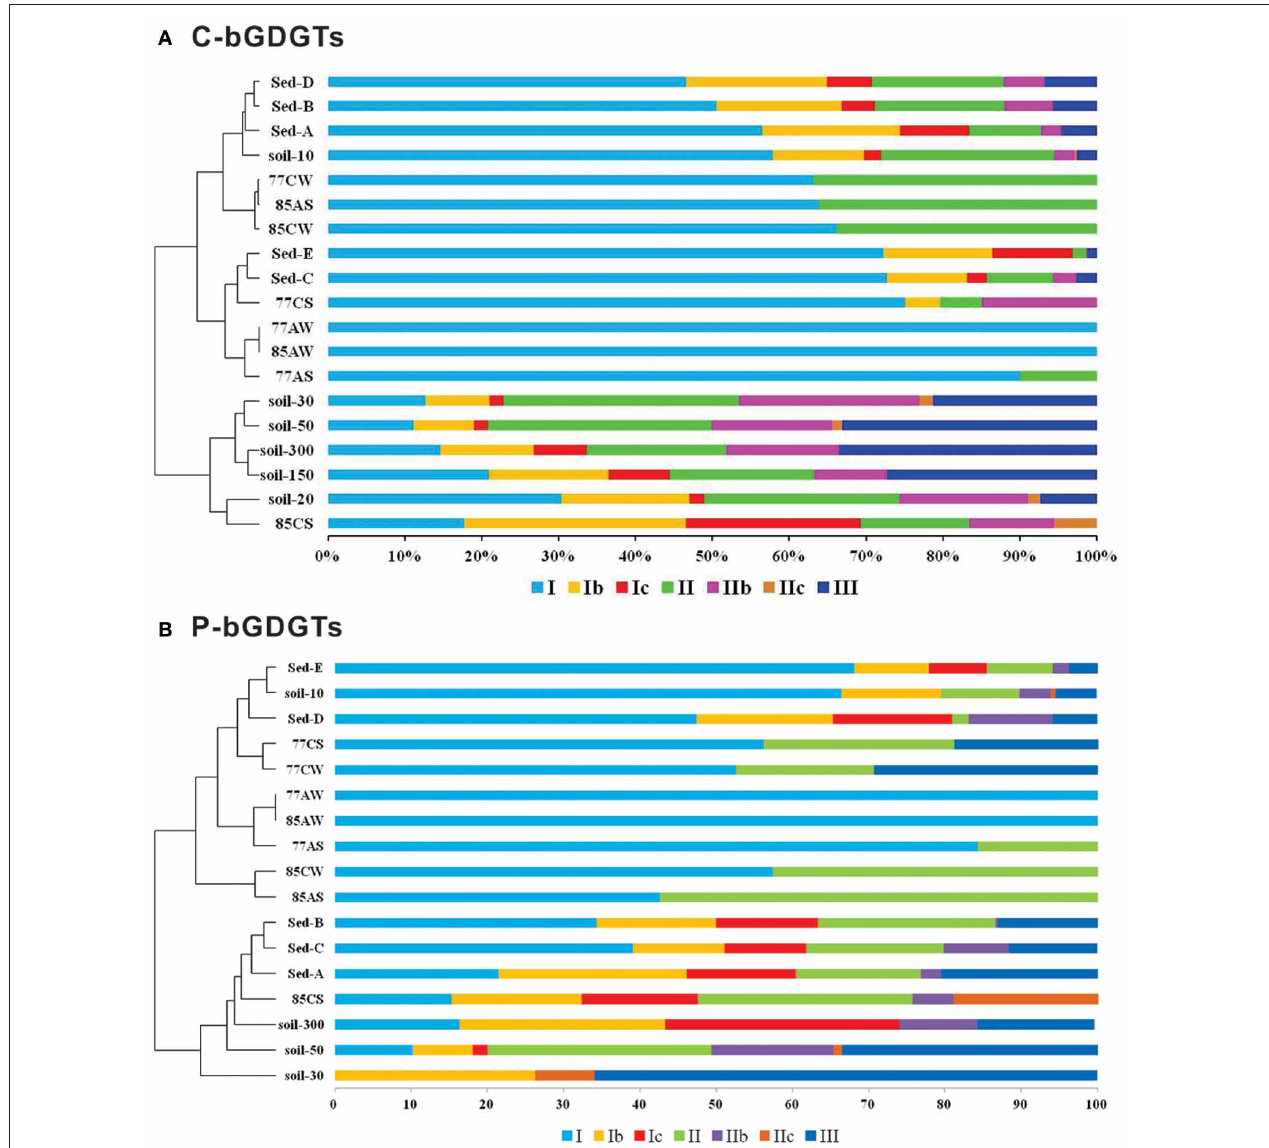
FIGURE 3 | Cluster analysis based on the relative abundance of C-bGDGTs (A) and hydrolysis-derived P-bGDGTs (B) from hot spring and soil samples, which distinguish the lipid profiles in hot spring sediments and cellulolytic enrichments from the majority of surrounding soil